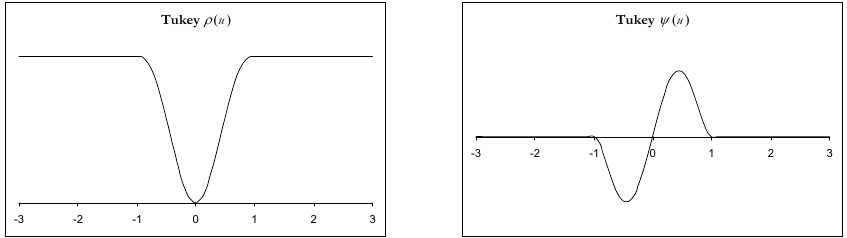
Figure 4 – Tukey’s function for k =1 (left panel) and the corresponding derivative (right panel). The redescending M -estimators are slightly more efficient than Huber’s